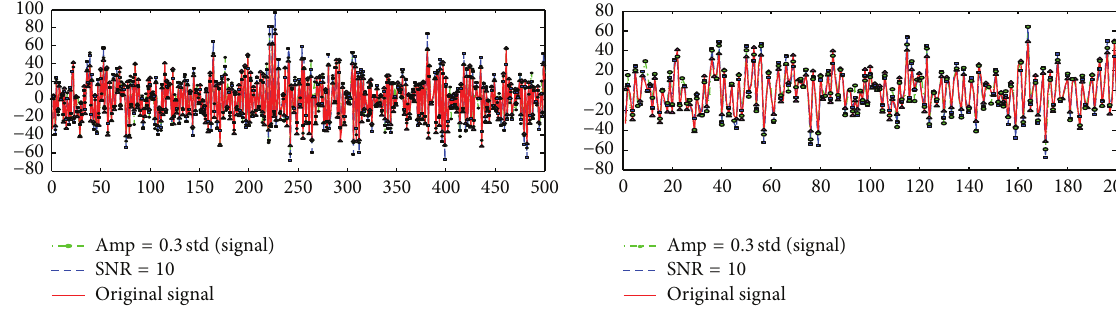
Figure 3: The influence of using constant amplitude (0.3 std (signal)) and the PIEEMD algorithm (SNR = 10) on extrema.